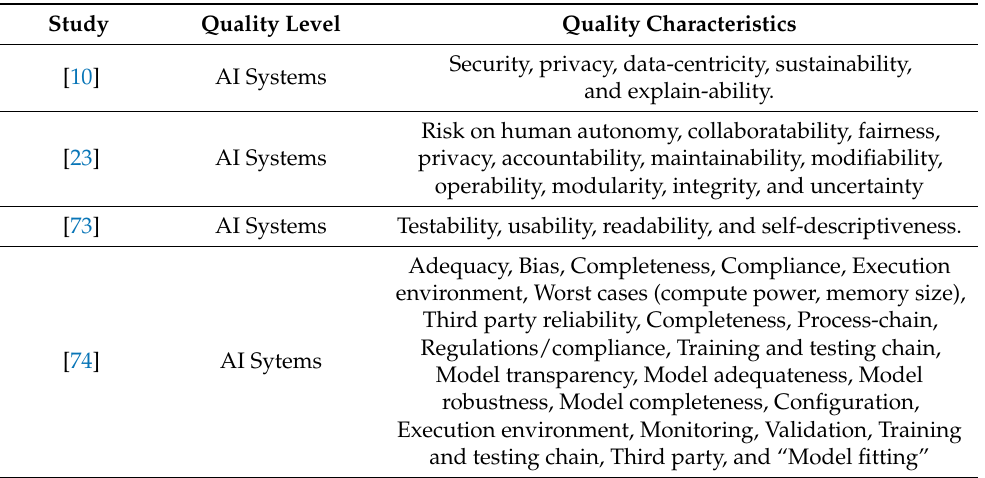
Table 8. Quality Characteristics for AI